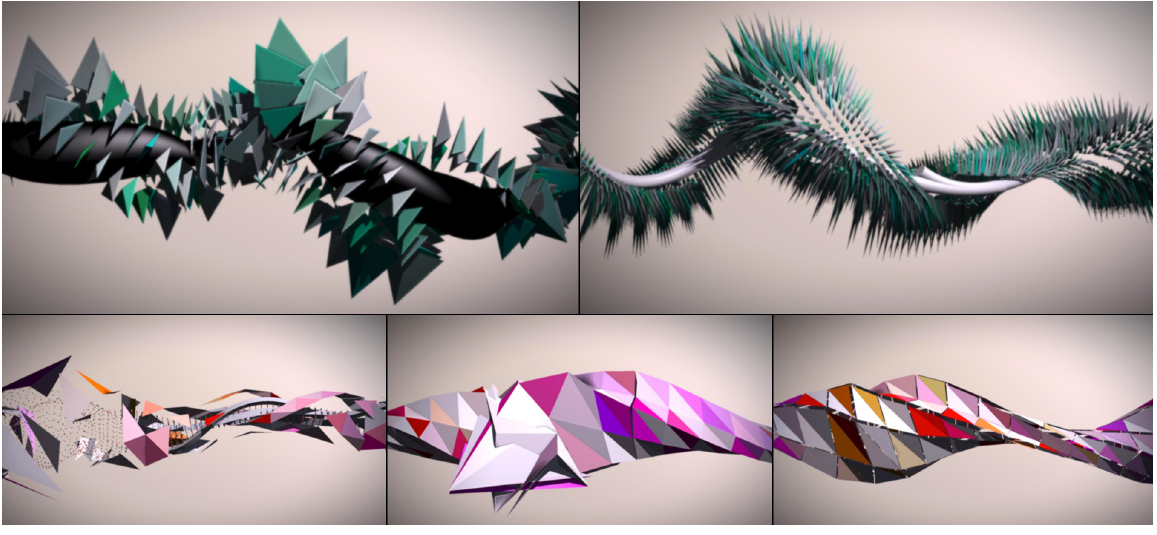
FIGURE 3 | “Partitura” sound